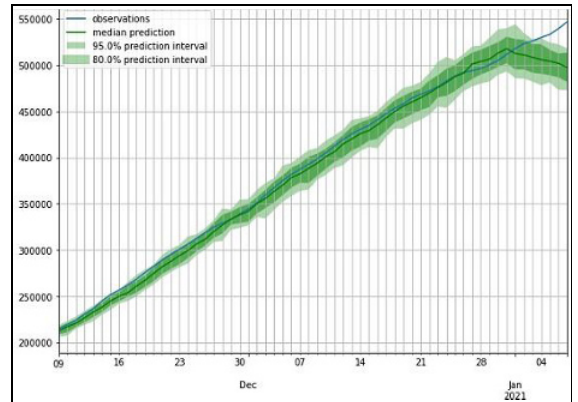
Fig.8. Fig. 8. DeepAR with LSTM cells “training data”